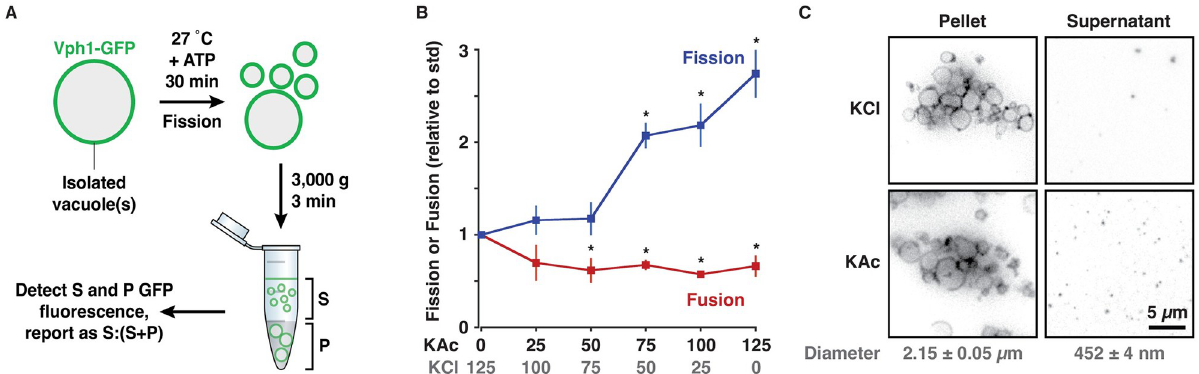
Fig 2. A new, simple cell-free vacuole membrane fission assay. (A) Cartoon depicting new fluorometric in vitro vacuole membrane fission assay. S, supernatant; P, Pellet. (B) Homotypic fusion or fission of isolated vacuoles in the presence of increasing concentrations of KAc in place of KCl. Means ± S.E.M. shown and P < 0.05 ( � ) as compared to standard conditions (125 mM KCl). (C) Micrographs of fission reactions containing vacuoles isolated from Vph1-GFP expressing yeast cells conducted in the presence of 125 mM KAc or KCl. Supernatants (containing fission products) and pellets (containing large vacuoles) are shown. Means ± S.E.M of vacuole diameters measured by quasi-elastic light scattering are indicated for each